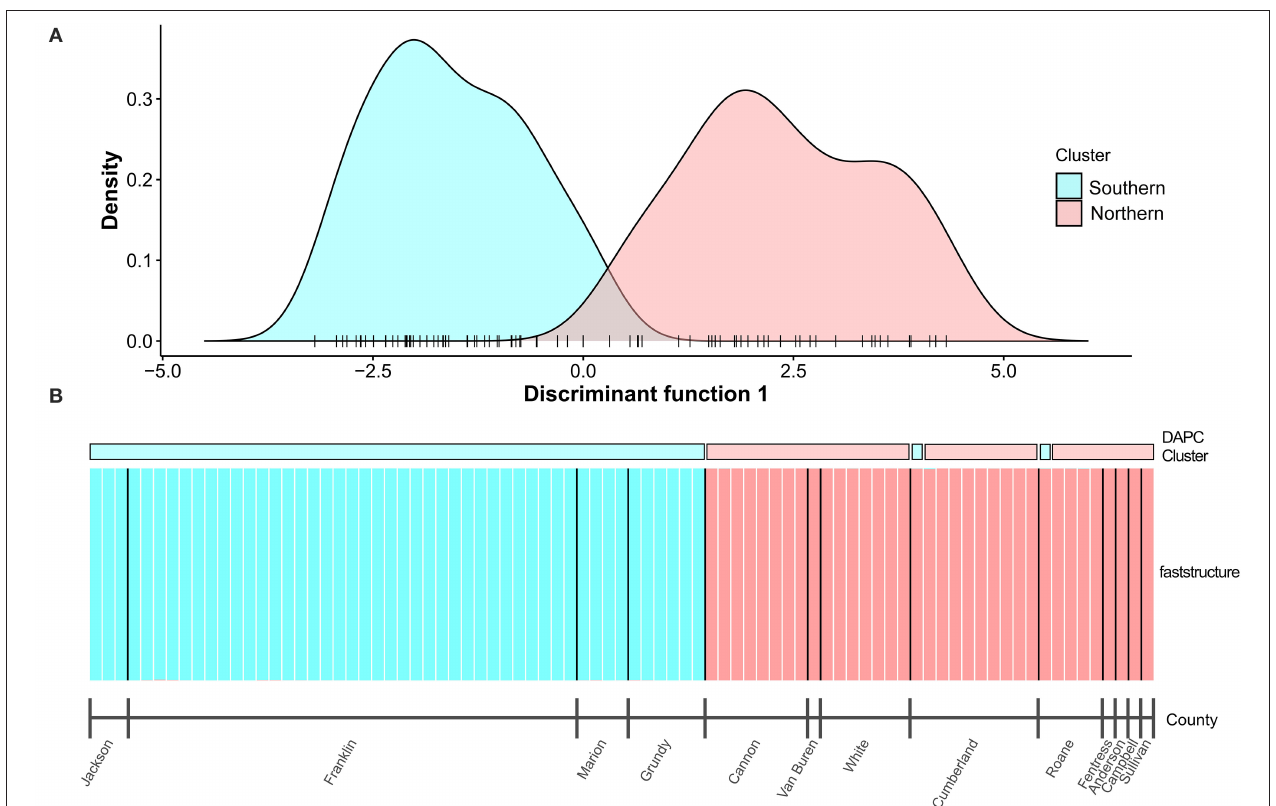
FIGURE 3 | Population assignments of both DAPC (A) and fastStructure (B) analyses for the nuclear SNP dataset supported two distinct genetic clusters ( K = 2) with little evidence of introgression. In (B) , each bar represents a single individual. Population assignments of two individuals were discordant between DAPC and fastStructure (as well as IQ-TREE; see Figure 4 ). Major lineages are highlighted.